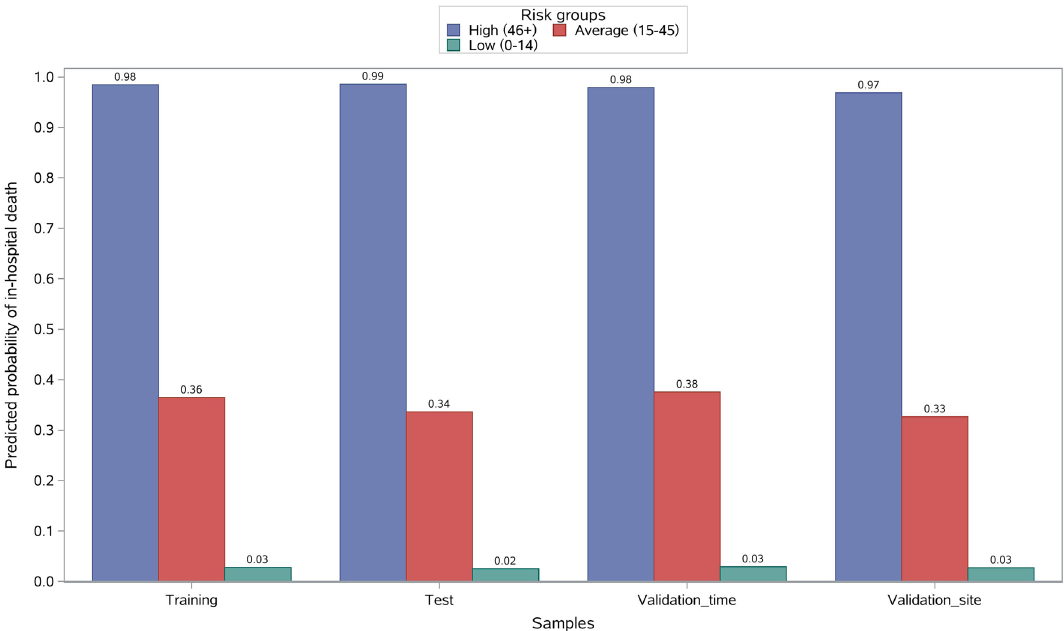
Figure 7. Risk stratification by risk scores. For the training, test, validation_time, and validation_site samples, respectively, the predicted probabilities of in-hospital death for PQ poisoning patients were 98%, 99%, 98%, and 97% in the highest risk group (46+), 59.9%, 62.2%, 59.4%, and 60.8% in the average-risk group (15–45), and 21.7%, 22.4%, 27.1%, and 36.7% in the lowest risk group